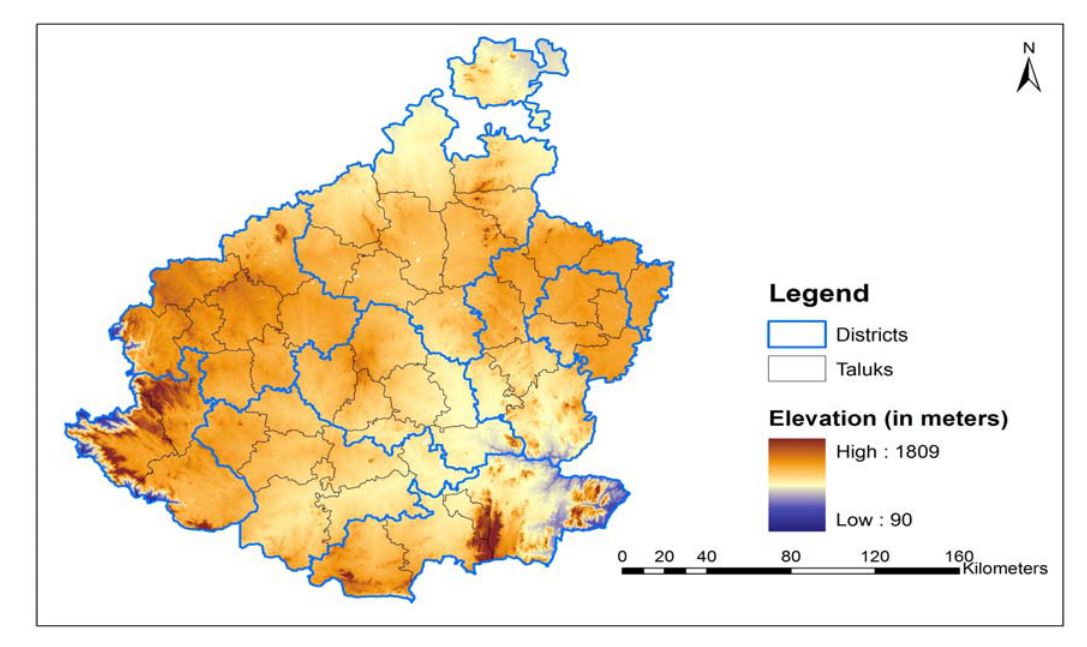
Figure 2. Distribution of elevation in study area.